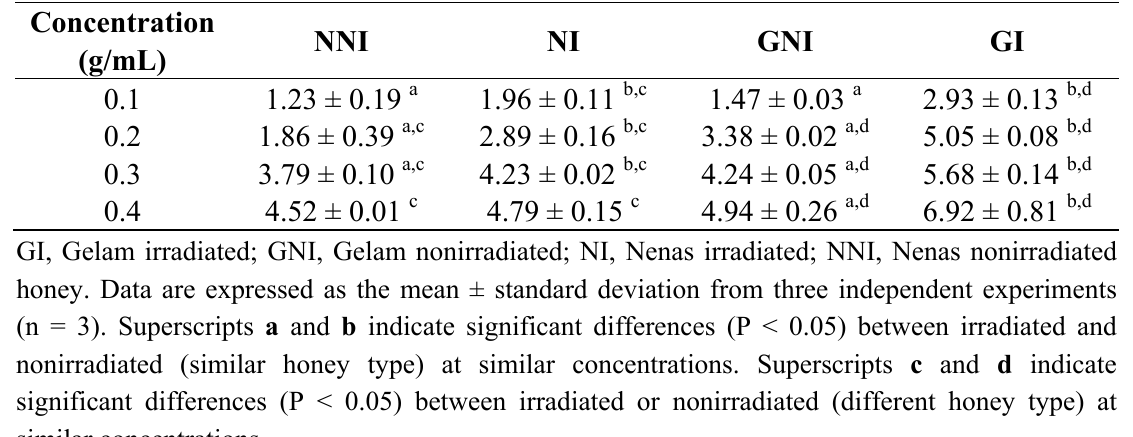
Table 3. Flavonoid contents (mg Rutin equivalent/100 g) of Gelam and Nenas honeys before and after